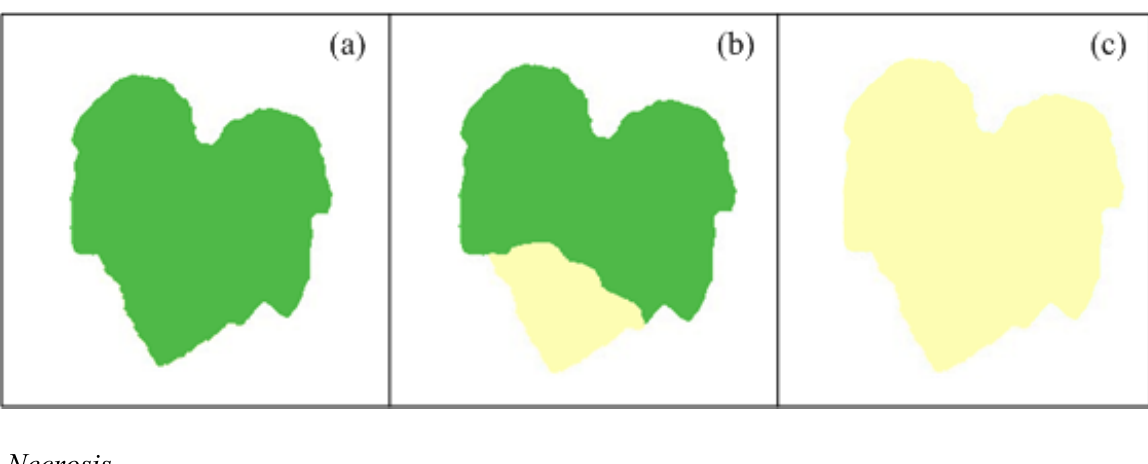
Figure 1. ( a ) Pumpkin leaf with healthy green colour. ( b ) Pumpkin leaf with localized chlorosis. ( c ) Pumpkin leaf with generalized chlorosis.